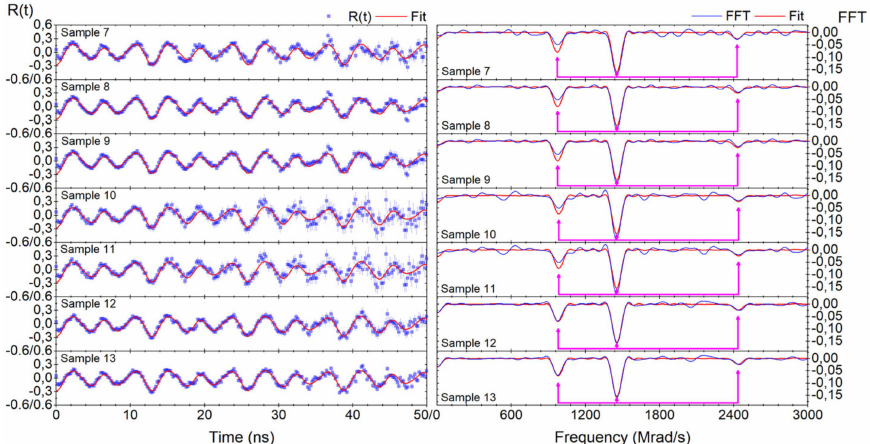
Figure 7. ( left ) R(t) graph and ( right ) corresponding FFT spectrum of the latter seven of the set of 13 different e − γ TDPAC measurements of 181 Ta(TiO 2 ). The additive constant is 0.0085. The TDPAC probe used is 181 Hf → 181 Ta, with the raw TDPAC spectrum (from the coincidence searches on the detectors) processed and converted into R(t) observables [see blue curves in the R(t) and their corresponding FFT graphs] by Interlude TM [see Equations (2)–(5)]. The R(t) signals are then fit by using the Gfit19 TM program [see red curves in R(t) and the corresponding FFT graphs]. For clarity, we show only the first 50 ns on the R(t) graph because shorter coincidence searches of e − γ rays are less noisy and thus more statistically significant than longer coincidence searches. The peaks of the FFT were marked with magenta arrows, with the values of the hyperfine parameters and the relevant experimental information tabulated in Table